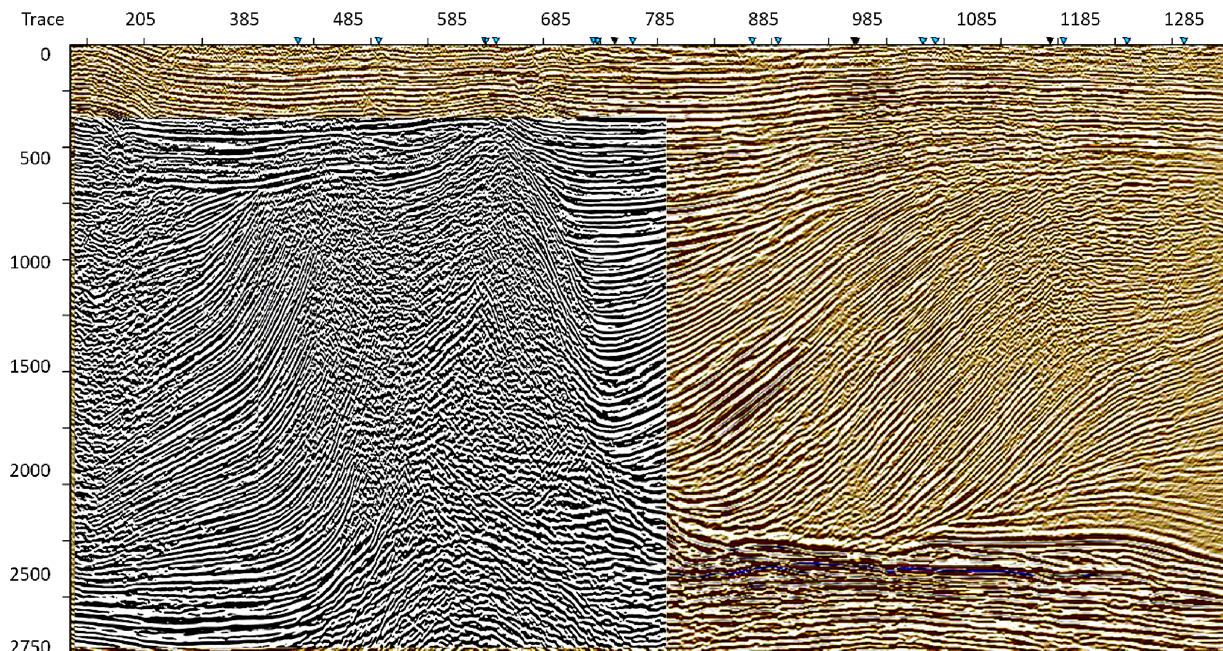
Fig. 5 Overhang trapped structure identified by 2D seismic pinpointed by cosine phase seismic